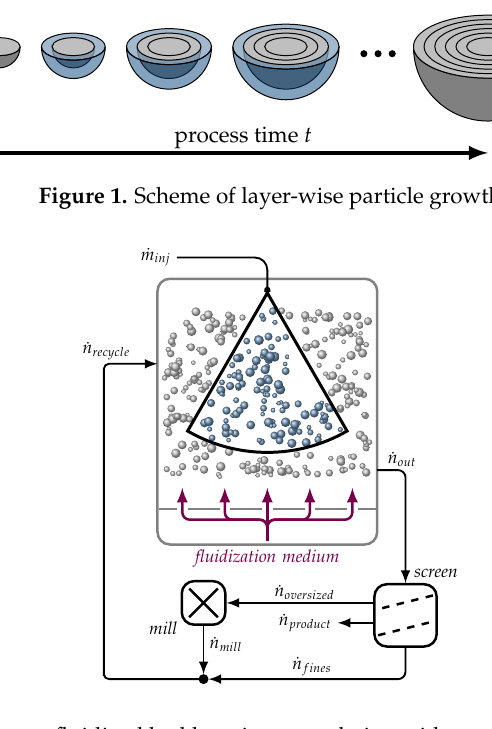
Figure 2. Continuous fluidized bed layering granulation with external